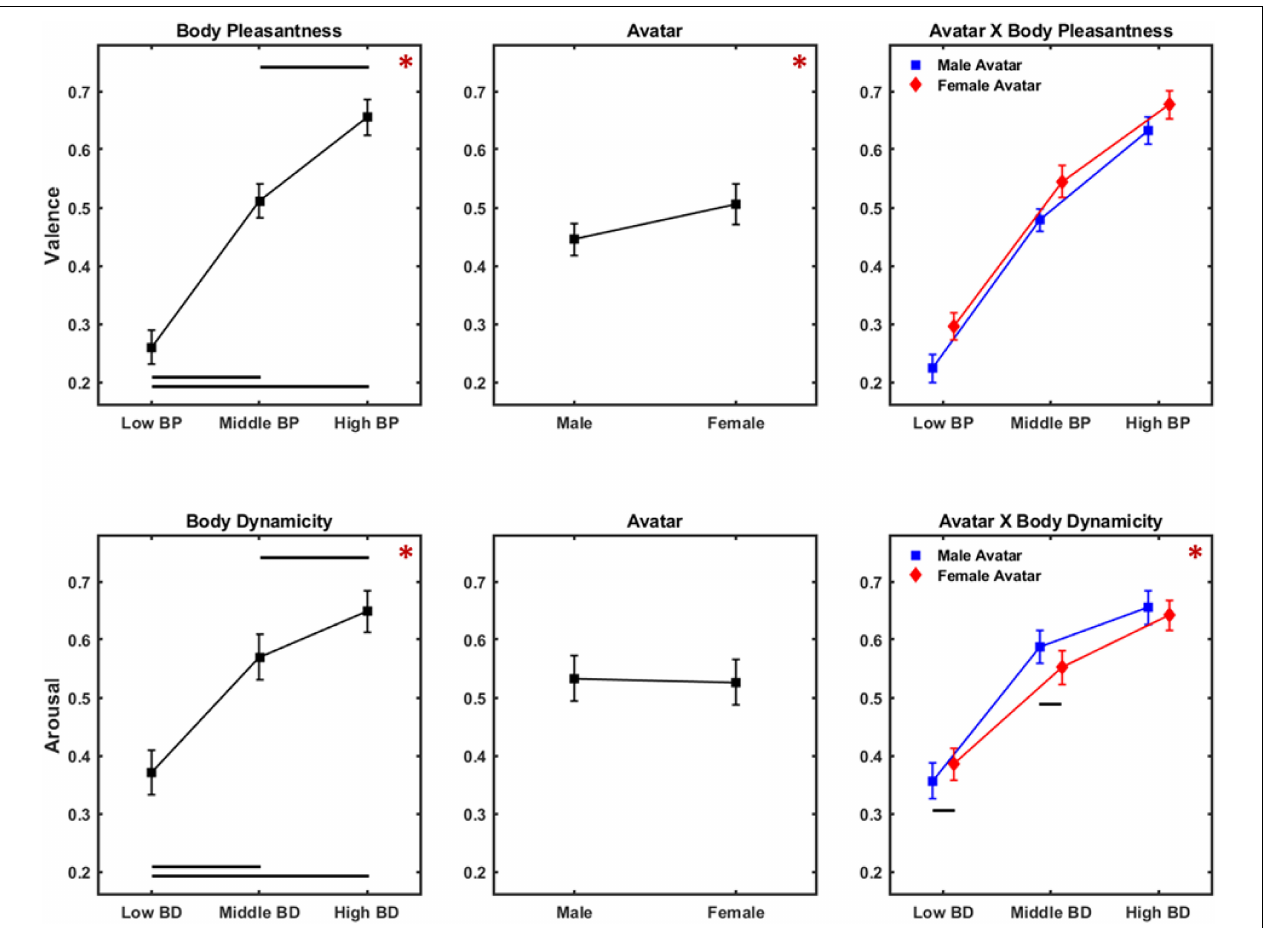
FIGURE 7 | Results of ANOVA on valence (Upper panels) and arousal (Lower panels) ratings for Experiment 2. (Upper panels) Present mean and 95% CI of the distribution of the valence scores for the main factors body pleasantness (Left) , avatar (Middle) , and the interaction avatar × body pleasantness (Right panel) . (Lower panels) Present mean and 95% CI of the distribution of the arousal scores for the main factors body dynamicity (Left) , avatar (Middle) , and the interaction avatar × body dynamicity (Right panel) . Same color code as Figure 4 .